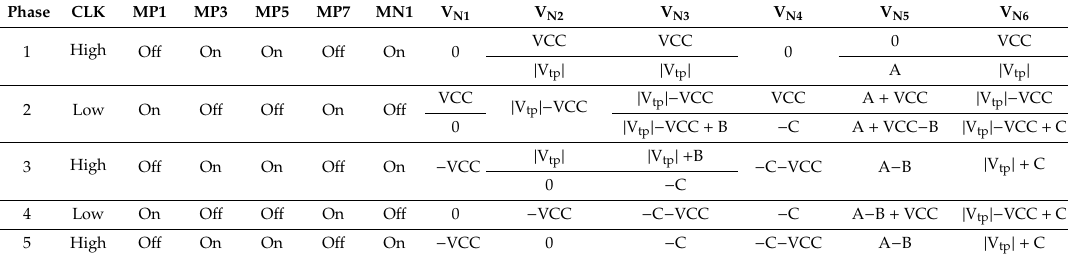
Figure 5. Proposed cross-coupled hybrid pumping circuit. Table 4. Sequential operation of the proposed circuit.